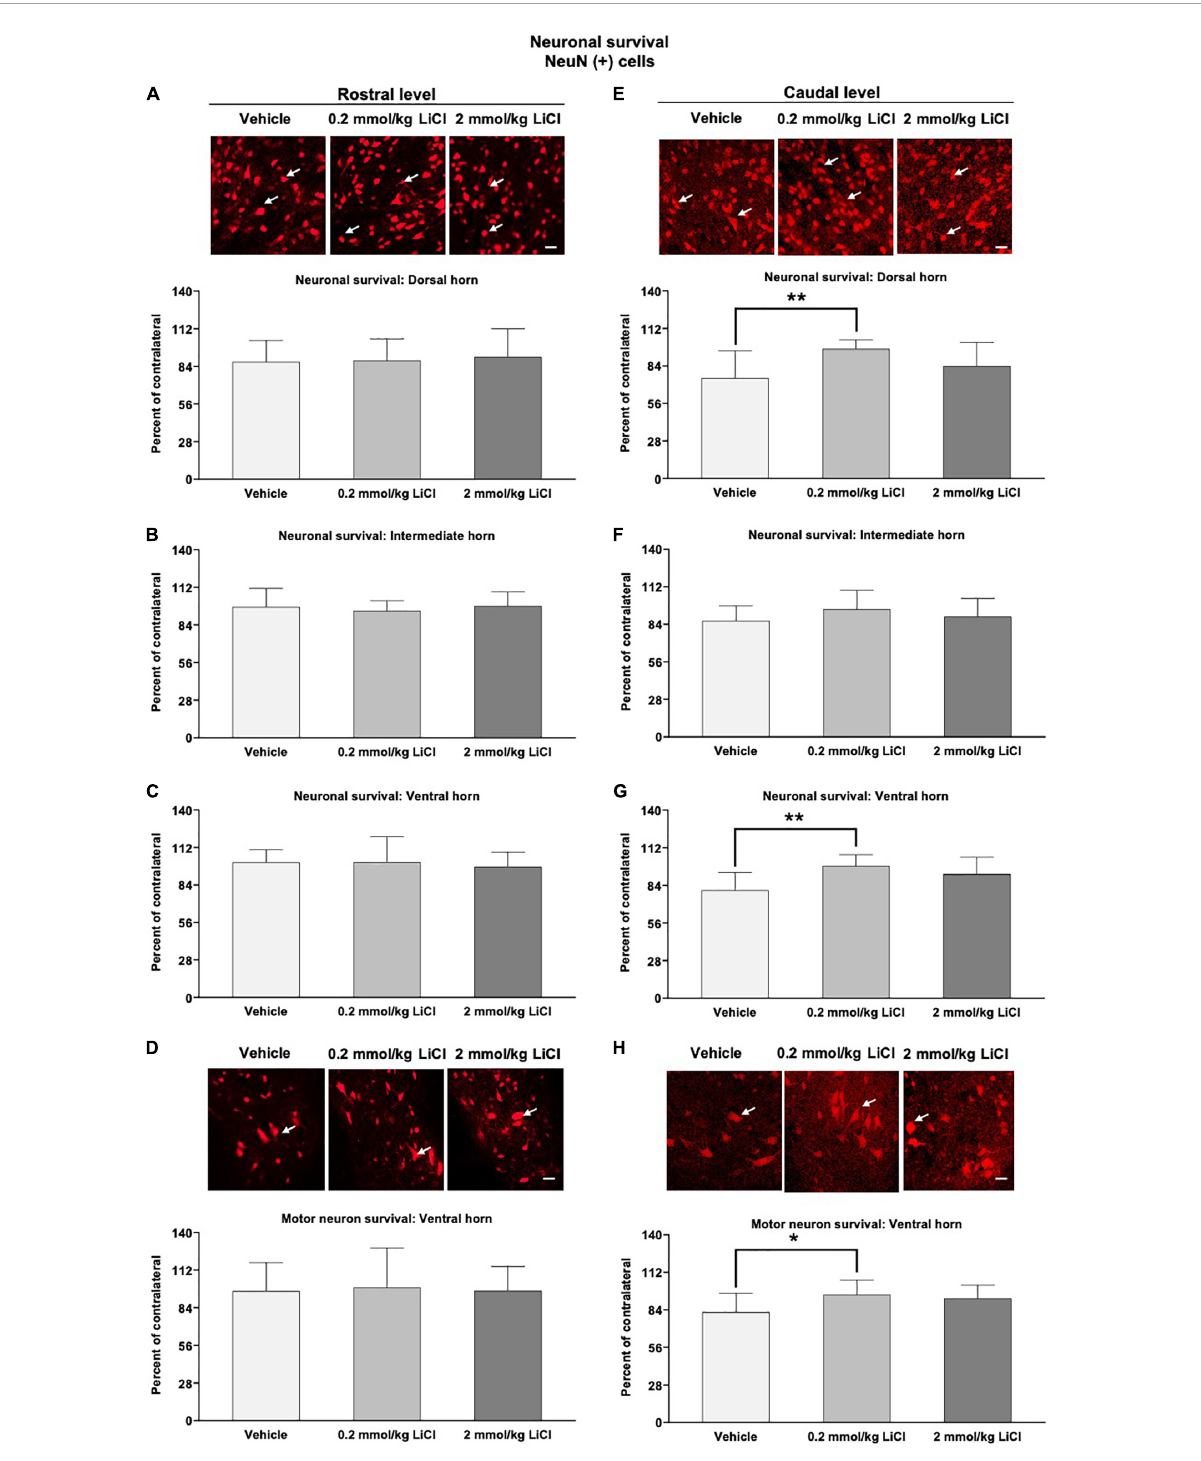
FIGURE4 Low-dose lithium prevents neuronal degeneration in the dorsal and ventral horns caudal to the hemitransection. Neuronal survival in (A,E) the dorsal horn, (B,F) the intermediate horn, and (C,G) the ventral horn of the spinal cord, as well as (D,H) survival of large-sized motor neurons in the spinal cord ventral horn assessed by NeuN immunohistochemistry at (A–D) the rostrocaudal level above the hemitransection (“Rostral level”) and (E–H) the rostrocaudal level below the hemitransection (“Caudal level”) of SCI mice, which were treated with vehicle or lithium (0.2 or 2 mmol/kg/day) for 56 days. Representative NeuN stainings are also shown. Data are mean ± SD values ( n = 16 animals/group). * p < 0.05/** p < 0.01 for 0.2 mmol/kg LiCl vs. vehicle. Please note that white arrows indicate representative neurons. Scale bars, 50 µ